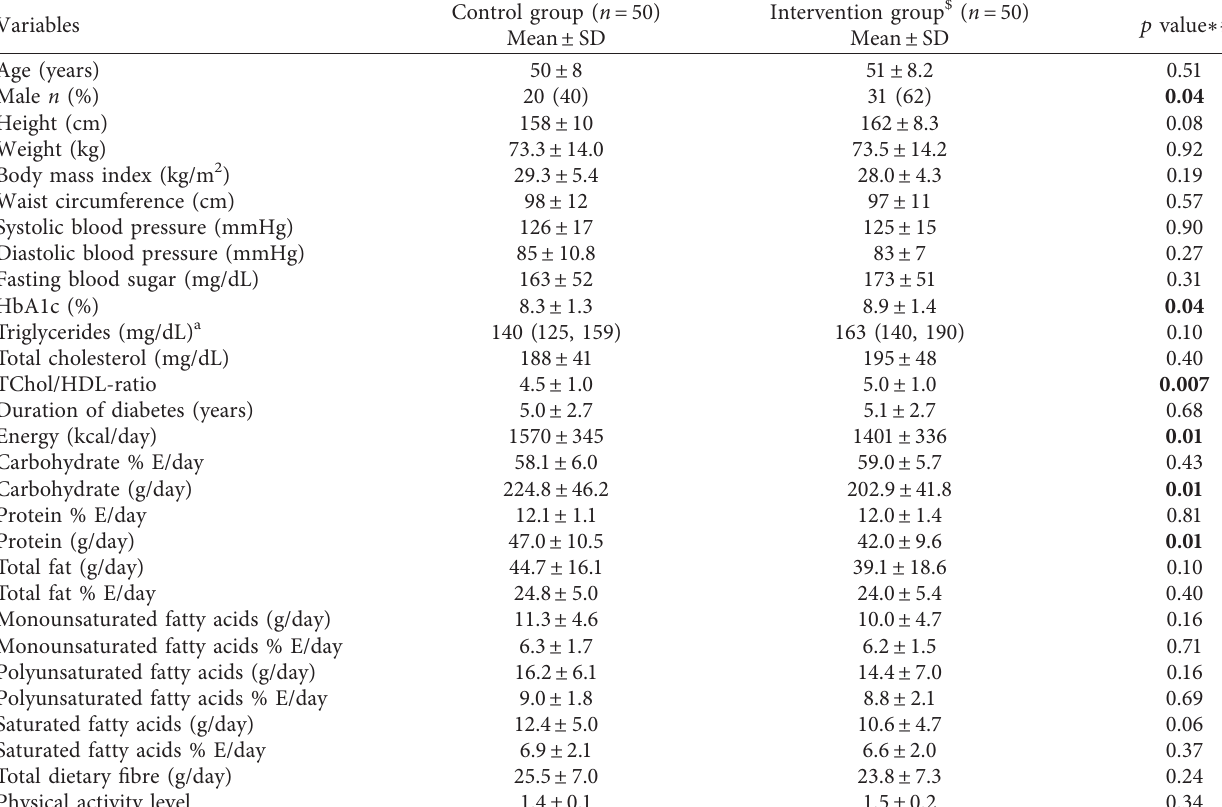
Table 2: Demographic and baseline characteristics of the study participants {intent to treat ( n � 100)}.